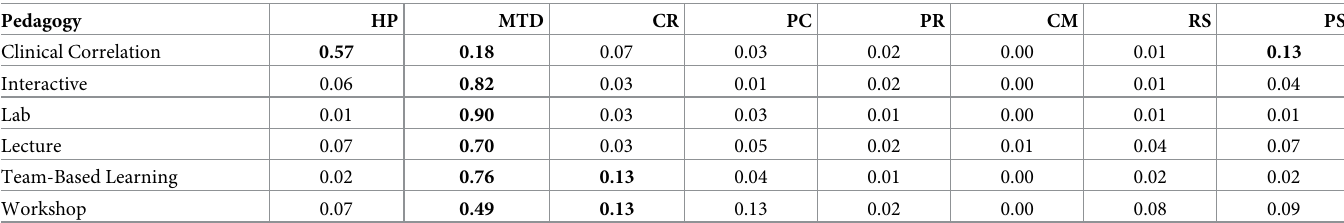
Table 4. Mapping pedagogies to competencies. Pedagogy